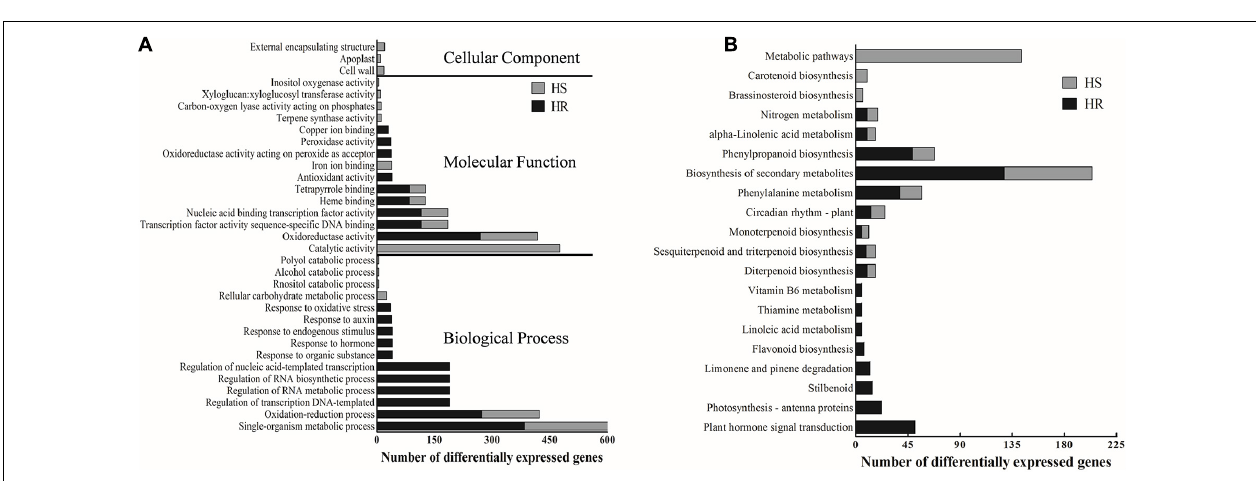
FIGURE 2 | Gene ontology (GO) and Kyoto Encyclopedia of Genes and Genomes (KEGG) analysis of the 2010 and 1,275 differentially expressed genes (DEGs) identified in Shidalukang 1 (HR) and Junmian 1 (HS) after Verticillium dahliae infection, respectively. (A) The top 20 significant ( P < 0.05) GO terms enriched in the 2010 and 1,275 DEGs identified in HR and HS, respectively. (B) The significant ( P < 0.05) KEGG pathways of the 2010 and 1275 DEGs identified in HR and HS,